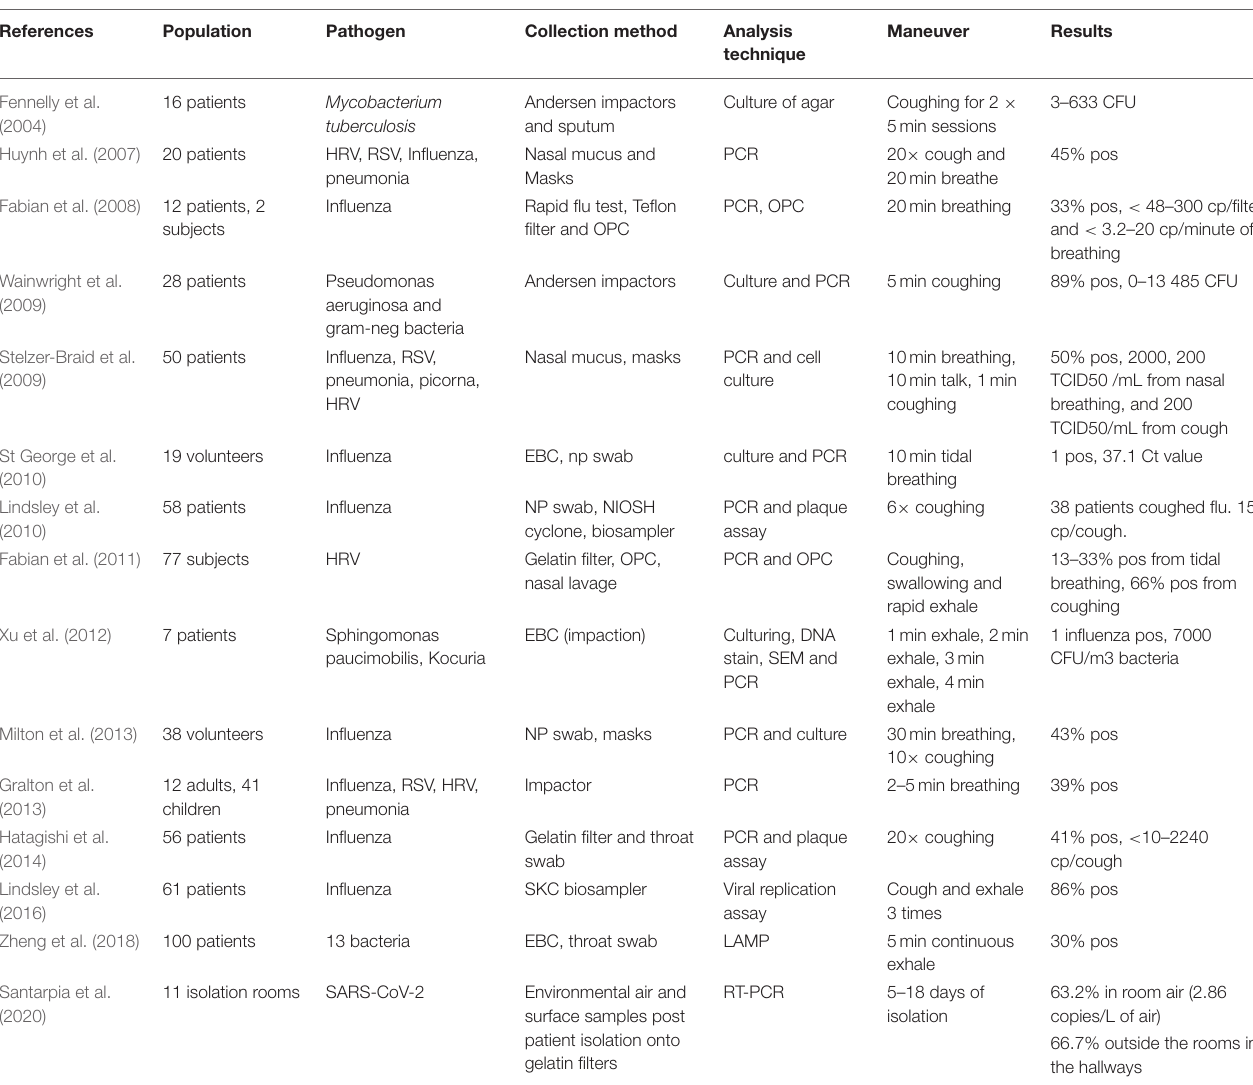
TABLE 2 | Summary of previous studies demonstrating detection of exhaled